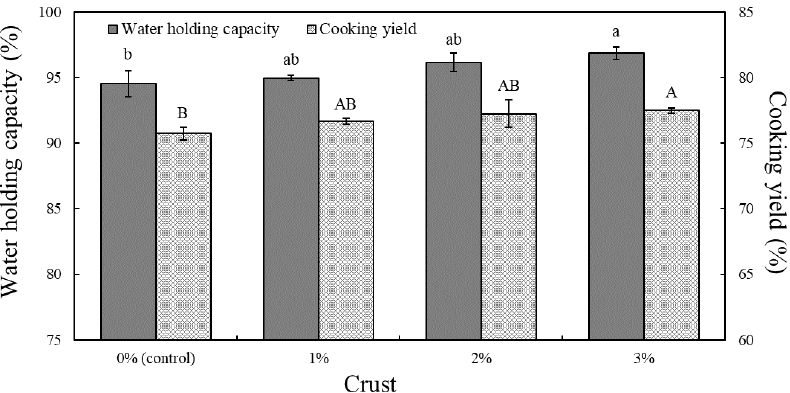
Figure 1. Water-holding capacity (WHC) and cooking yield of pork patties formulated with various levels of crust derived from dry-aged beef (Hanwoo). a,b,A,B represent statistically significant differences comparing the same color bar graphs ( p < 0.05).